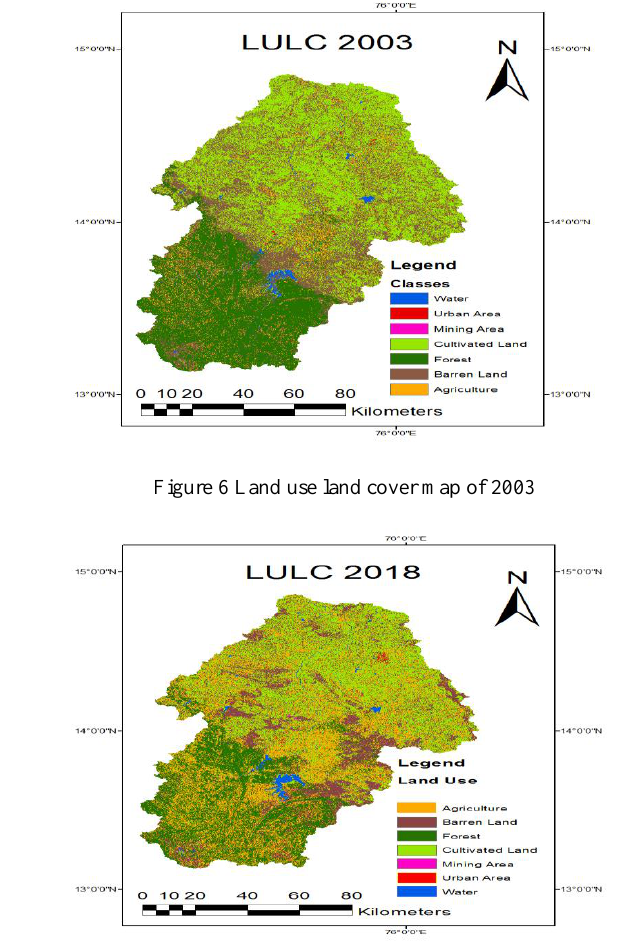
Figure 7 Land use land cover map of